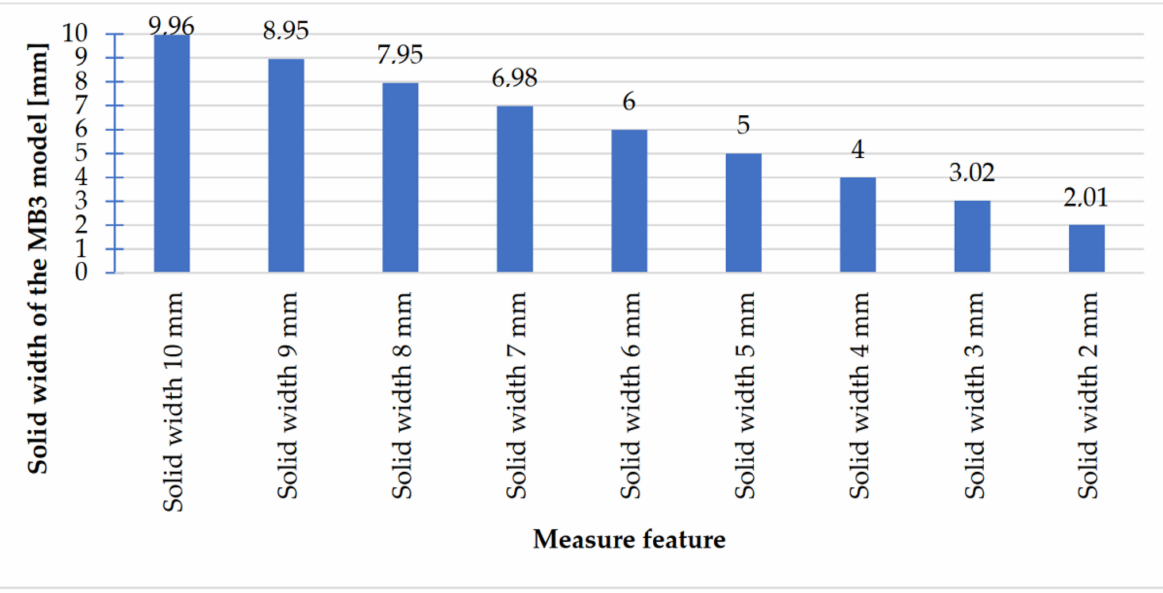
Figure 25. Measured values of rectangular solids with dimensions 10–2